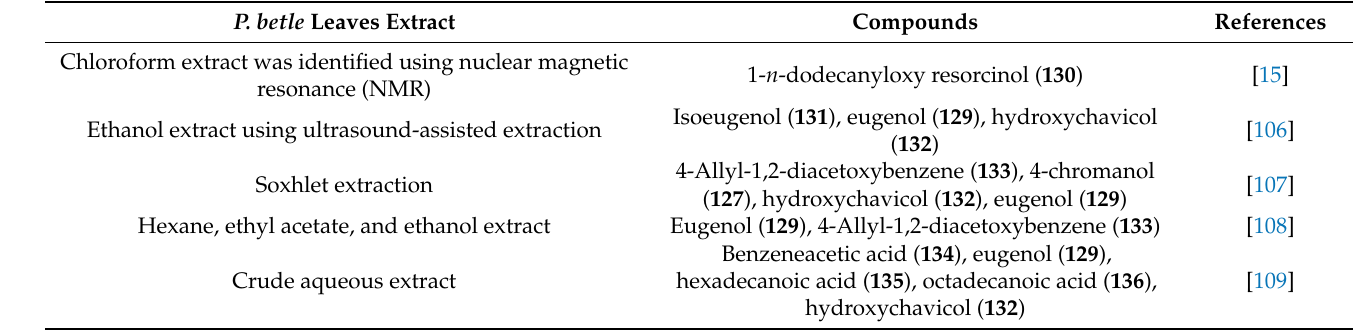
Table 2. List of isolated bioactive compounds identified from leaves extract of P. betle .